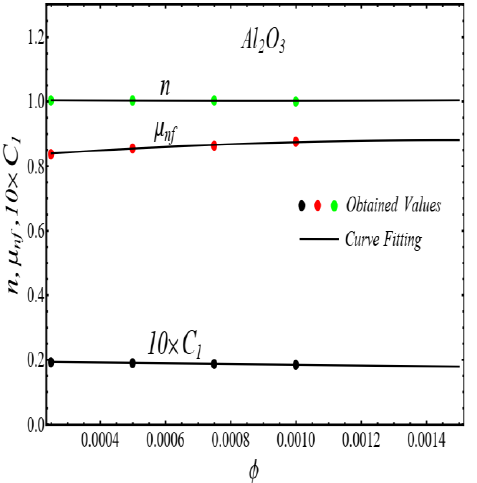
Figure 6. Fitting the Equation (3) for data in Table 1.